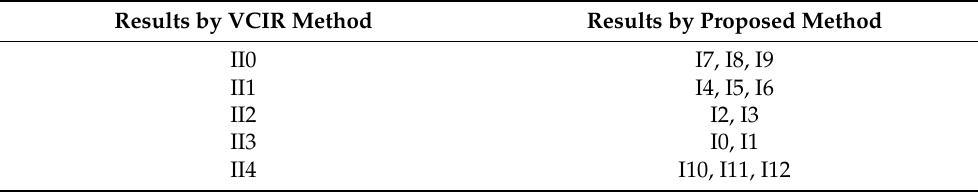
Table 5. Comparison of the two methods’ extraction results with the IQmulus & TerraMobilita Contest